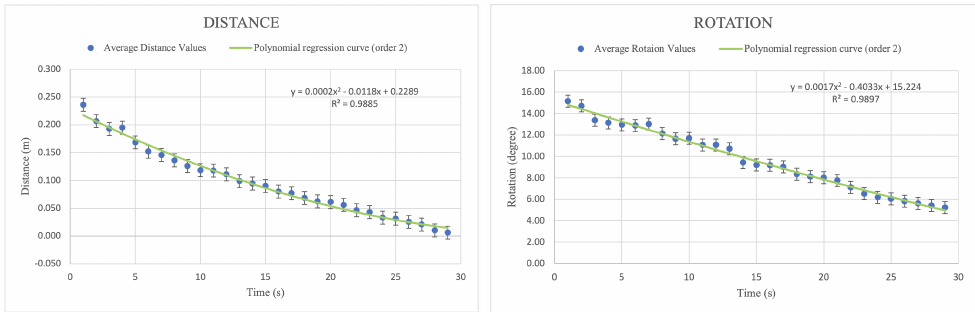
Figure 6. Experimental mean distance and rotation values. The polynomial curve of order 2 is overlapped showing a decreasing